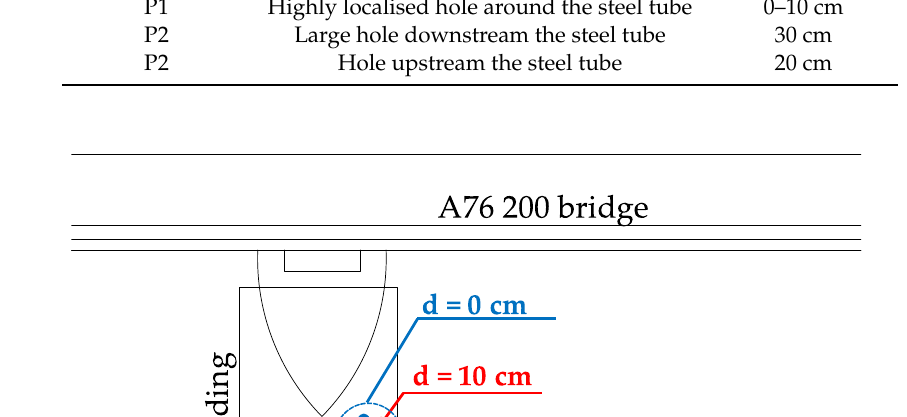
Table 5. Scour inspection—Locations and scour measurements.